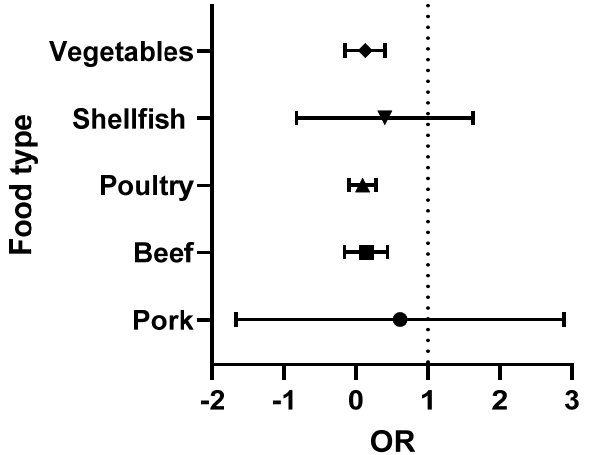
Figure 2. Forest plot of the OR of C. difficile (all ribotypes) in each food type.